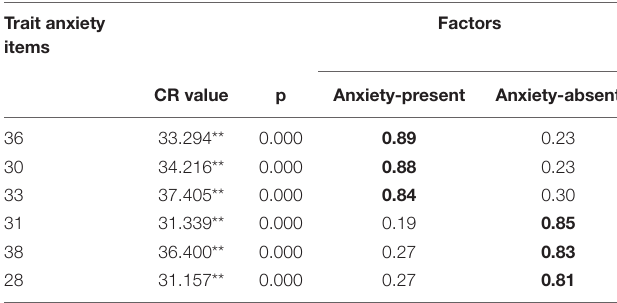
TABLE 7 | Principal axis factor analysis loading of the STAI-T-6 scale items following varimax rotation ( n =